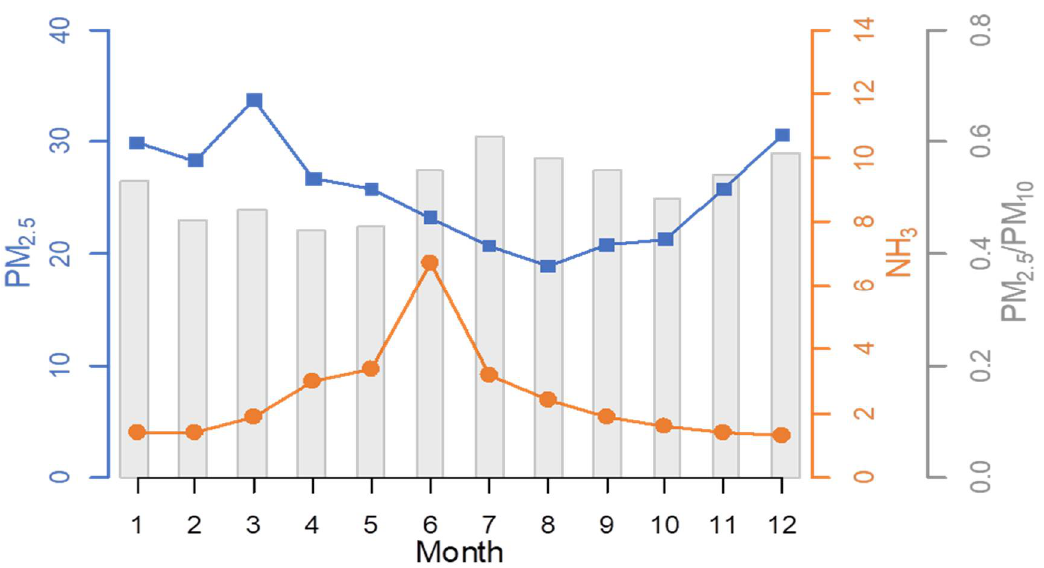
Figure 5. Three-year monthly variations of PM 2.5 (blue line), CrIS NH 3 (orange line), and PM 2.5 /PM 10 ratio (%, gray bars) over the SMA. These data were averaged from the measurements estimated with 15 km-grids (shown in Figure 3).